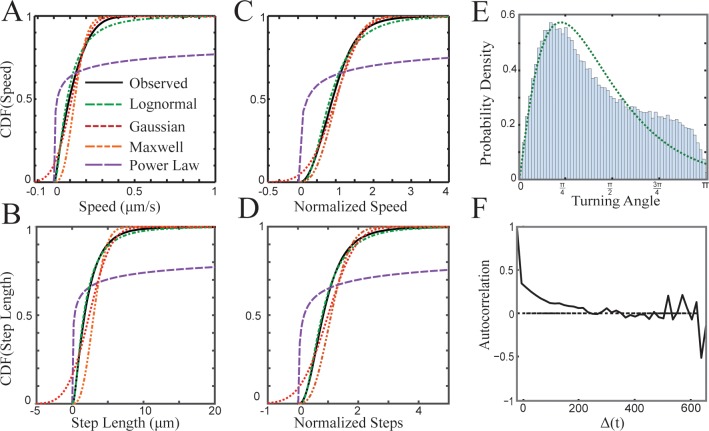
Distributions of T cell speed and step lengths with MLE fits.For (A) speed and (C) step length the lognormal function is the best fit (see Tables 1 and 2 for likelihood values and model parameters). Fits for normalized speed (B) and normalized step lengths (D) are divided by the mean speed or step length of the track from which they are drawn. (E) Histogram of all 149,592 observed turning angles. The green line is the maximum likelihood estimation of the gamma distribution used to model turning angles in the efficiency simulation. (F) Turning angle autocorrelation for 23,169 vectors from the 537 T cell tracks observed in one dataset. The correlation in movement direction decays until reaching zero at approximately 240 s.